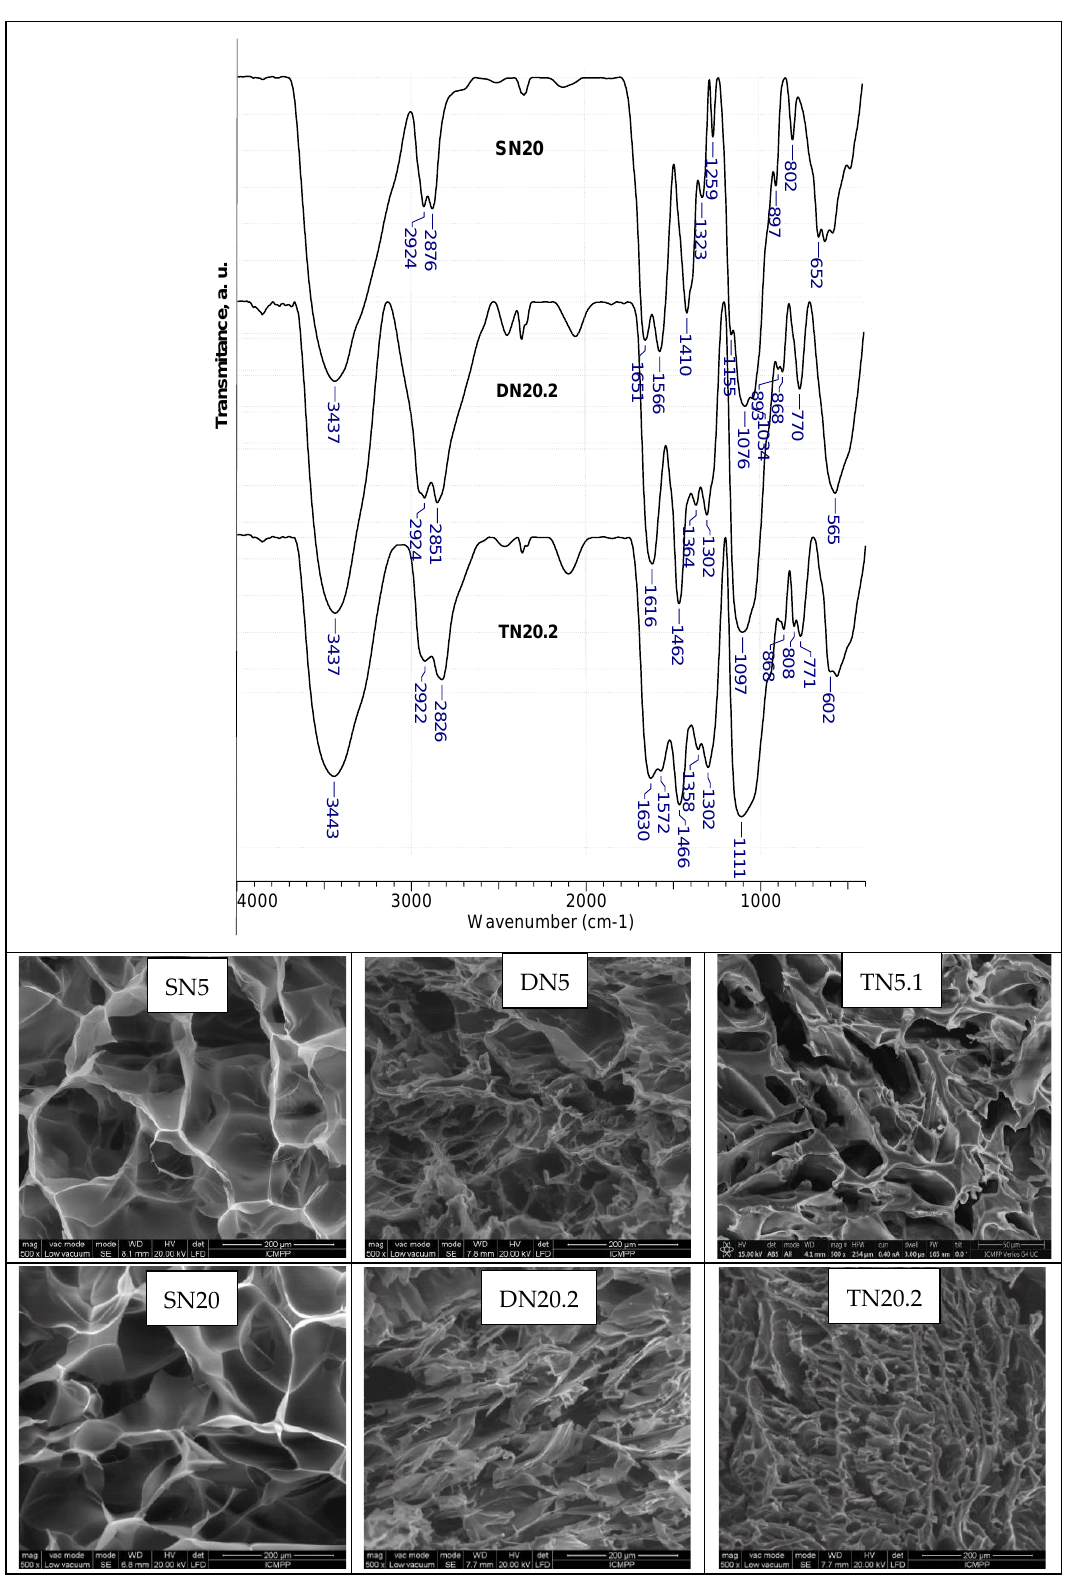
Figure 2. FTIR spectra of SN20, DN20.2 and TN20.2 (Table 1) (up) and SEM images of SN5, DN5, TN5.1, SN20, DN20.2 and TN20.2 (Table 1) (down) with scale bar of 200 µm and magnification of 500x.